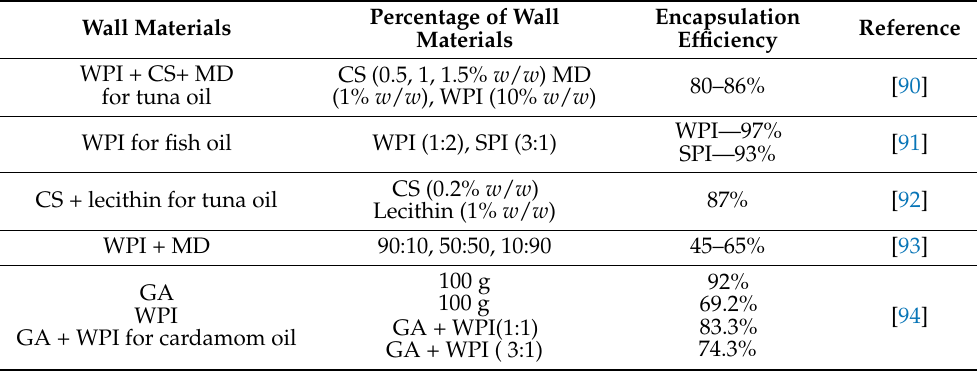
Table 3. Examples of materials that have been used as wall materials for microencapsulation of fish oil. WPI, whey protein isolate; CS, chitosan; MD, maltodextrin; GA, gum arabic; SPI, soy protein